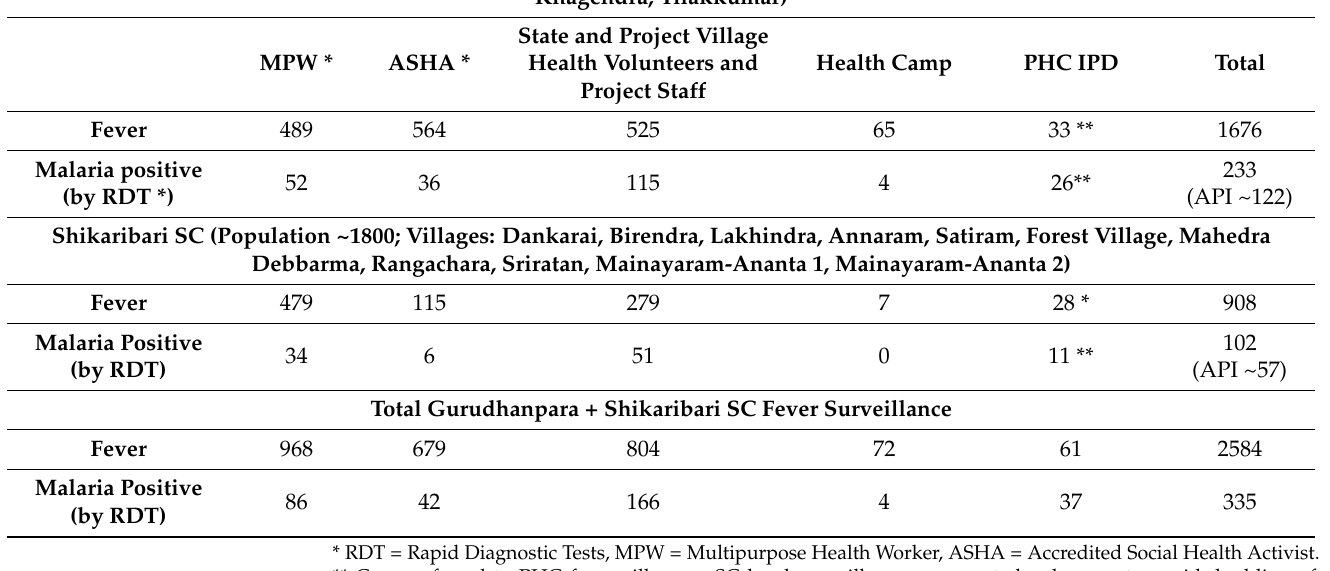
Table 2. Total no. of fever and malaria cases reported in Gurudhanpara and Shikaribari SC area during April 2019 to March 2020 period.